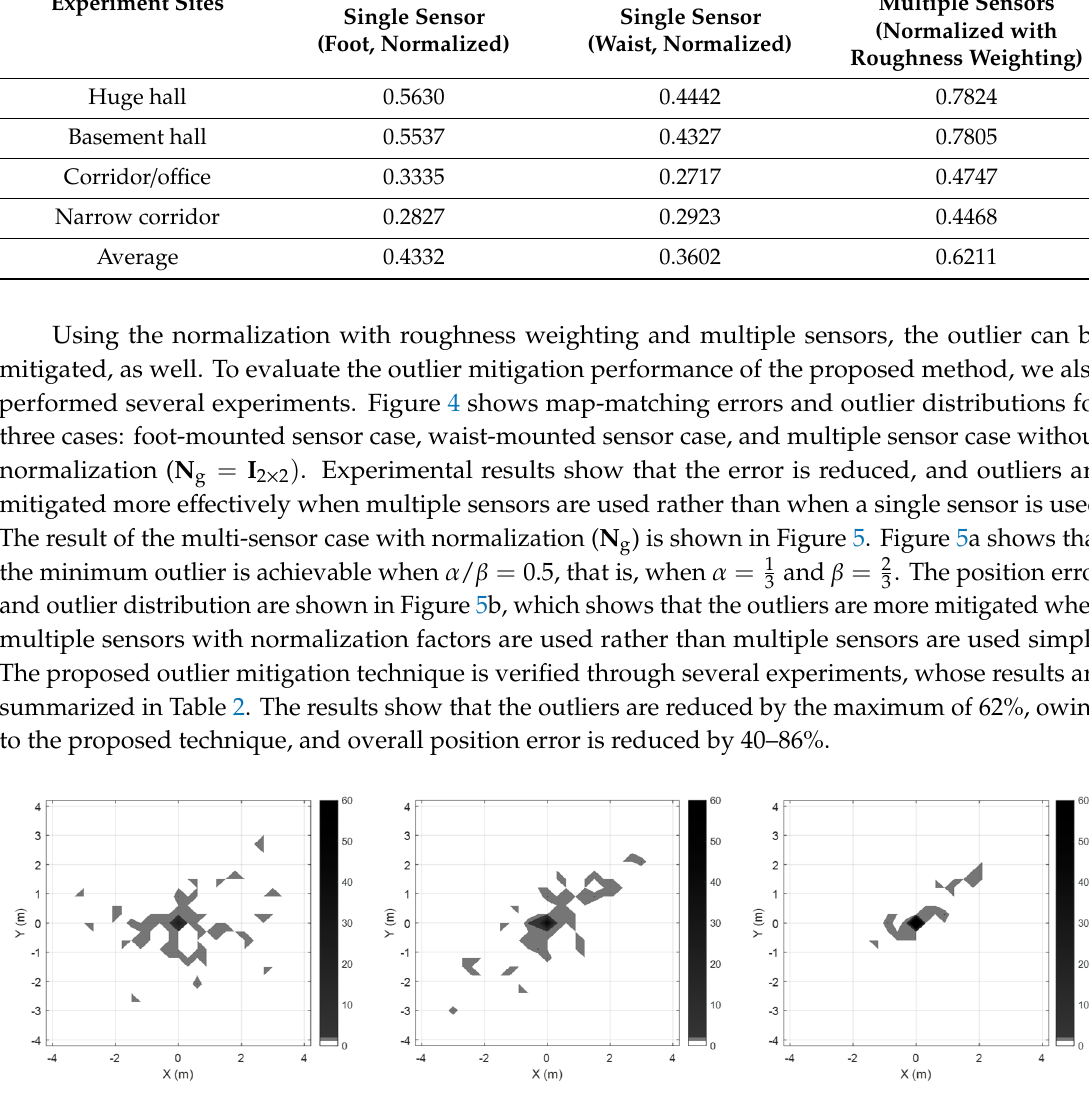
Figure 4. Position map-matching errors and outlier distributions for three cases (( Left ) foot-mounted sensor, ( Middle ) waist-mounted sensor, and ( Right ) multiple sensor case with simple integration).